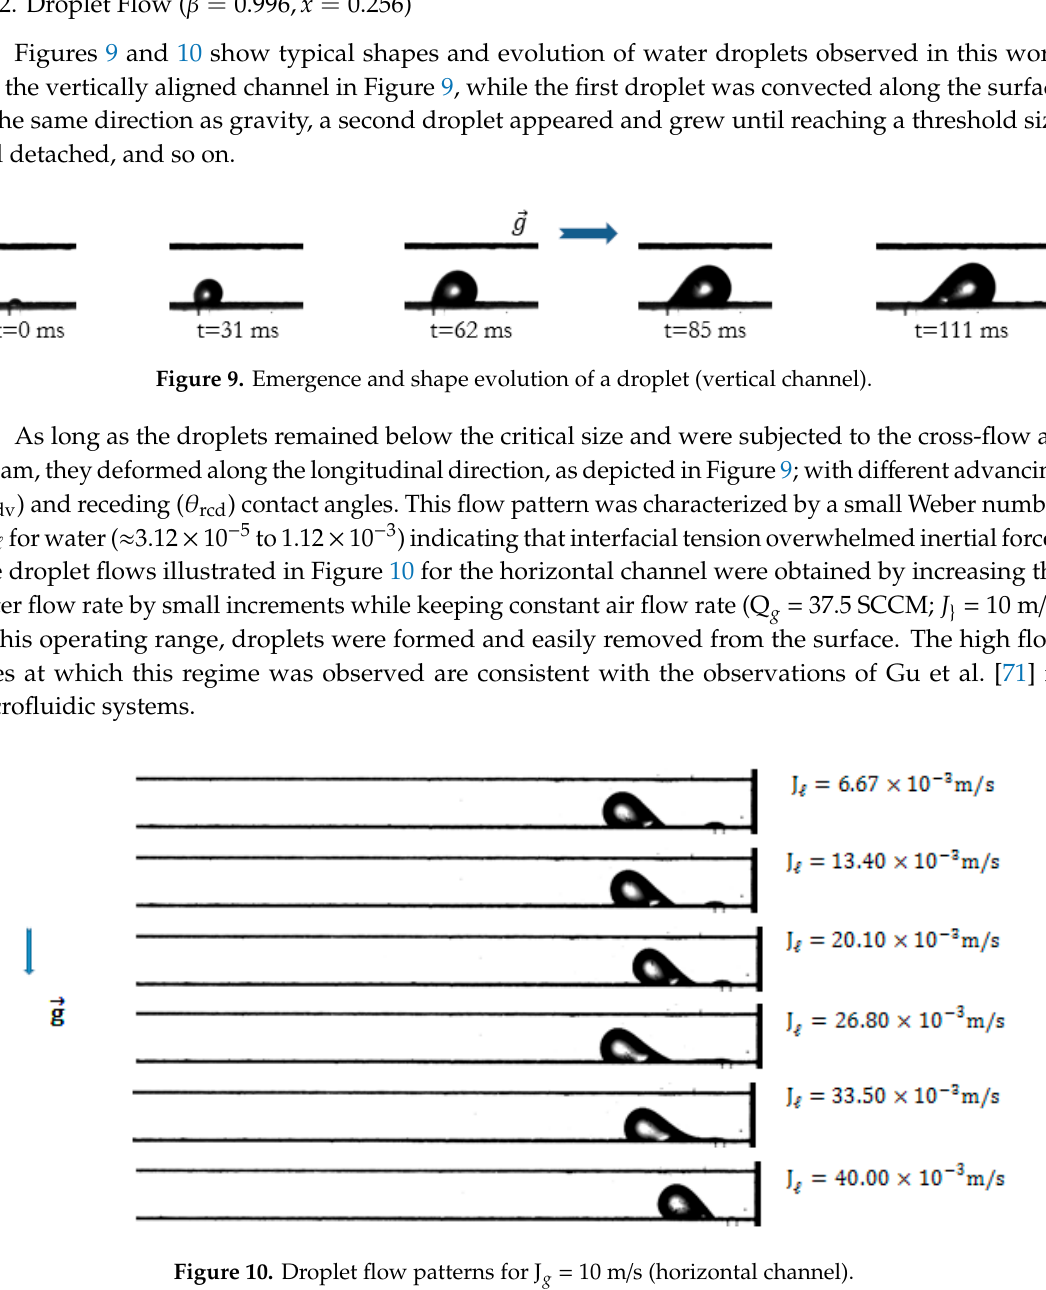
Figure 8. High-speed images of a convex liquid bridge: liquid is accumulated into the pore, forms a capillary, propagates, and splits into three convex plugs.